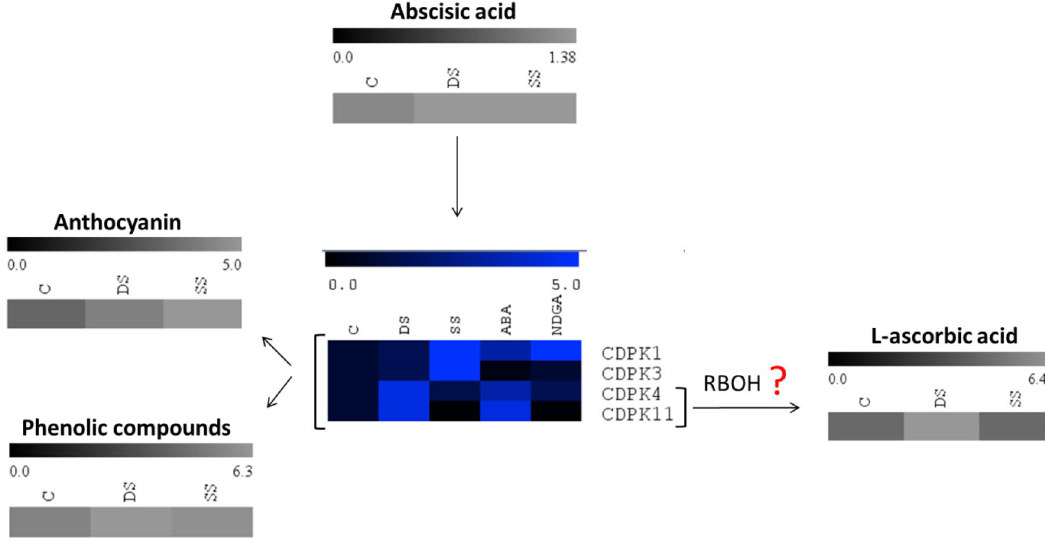
Figure 8. Simplified scheme of possible CDPK actuations under osmotic stress